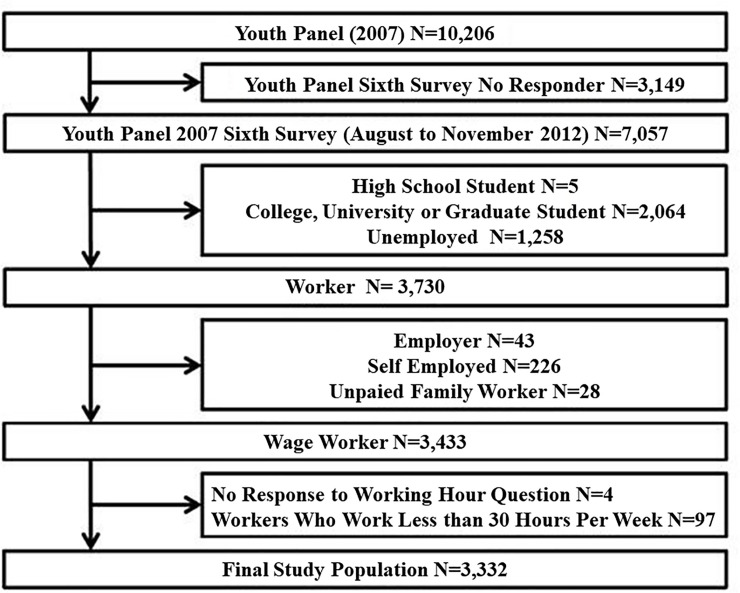
Study population & design.